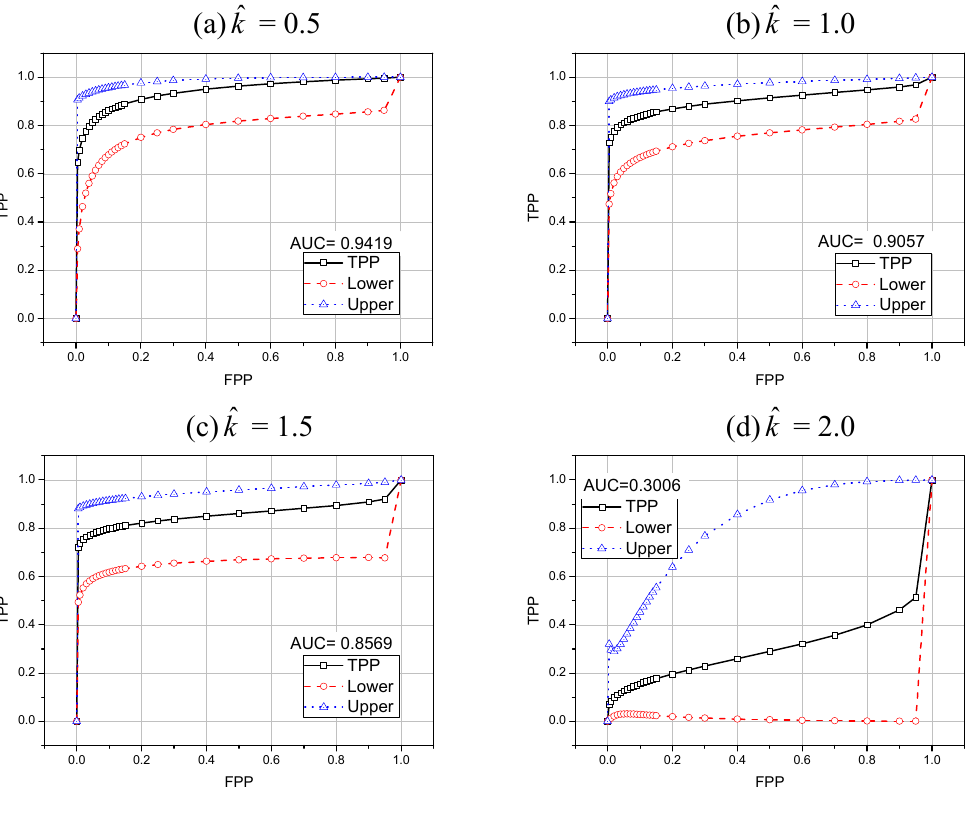
Figure 13. ROC curves when attacking traffic rate is 5 times faster than normal traffic